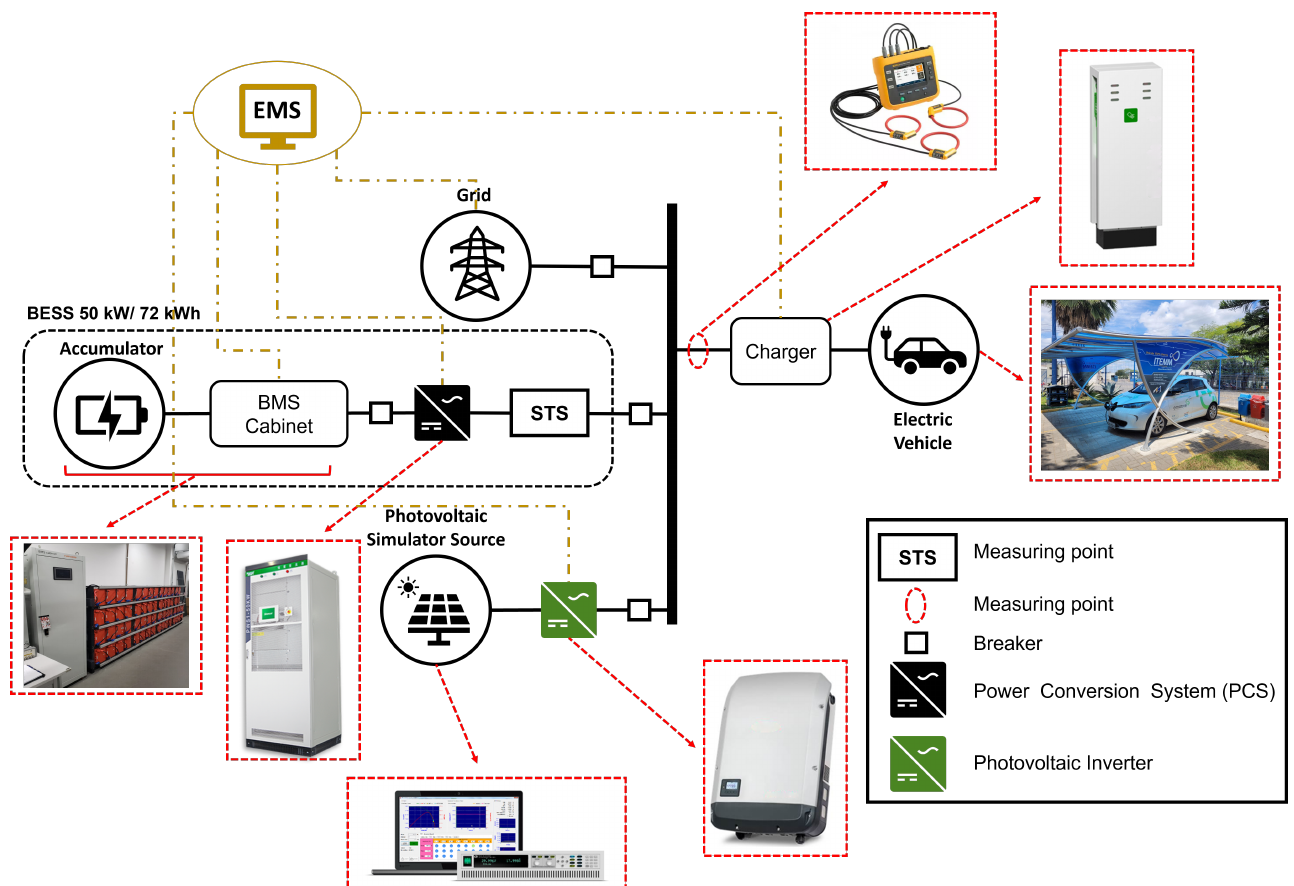
Figure 2. Configuration of Recharge